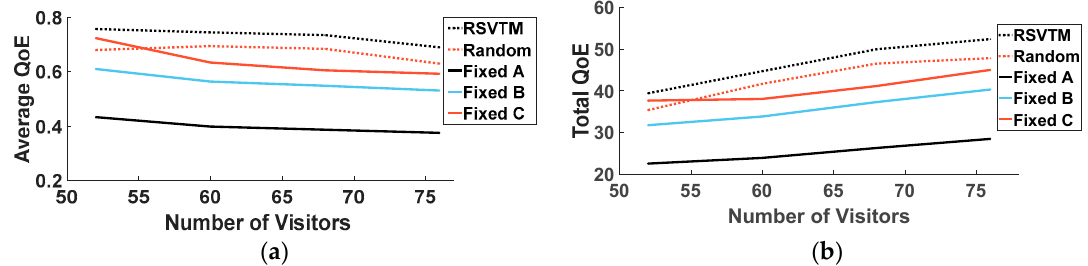
Figure 8. QoE as a function of the number of visitors for all the comparative scenarios. ( a ) Average QoE. ( b ) Total QoE.